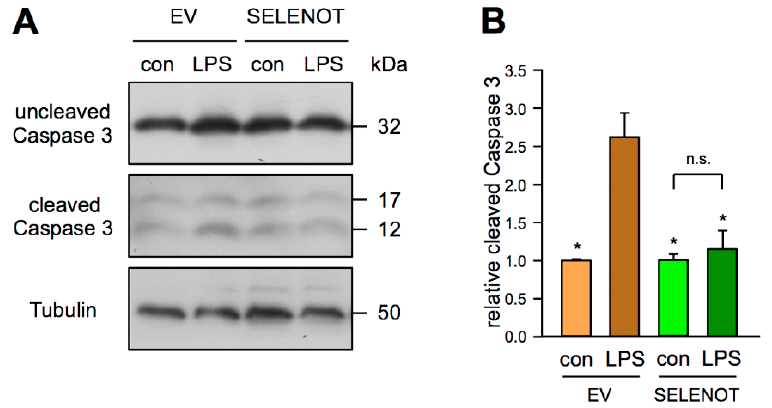
Figure 5. SELENOT suppresses apoptosis induction by LPS. ( A , B ) EC were transfected with the FLAG-SELENOT expression vector (SELENOT) or an empty vector (EV) and treated with 150 ng/mL detoxified (con) or active LPS (LPS) for 18 h. Uncleaved and cleaved Caspase 3 were detected by immunoblot, Tubulin served as loading control. ( A ) Representative immunoblot. ( B ) Semi-quan- titative analysis of relative amounts of cleaved Caspase 3 (data are mean ± SEM, n = 4, * p < 0.05 vs. EV/LPS, n.s. = not significant, one-way ANOVA with post-hoc Tukey LSD test).